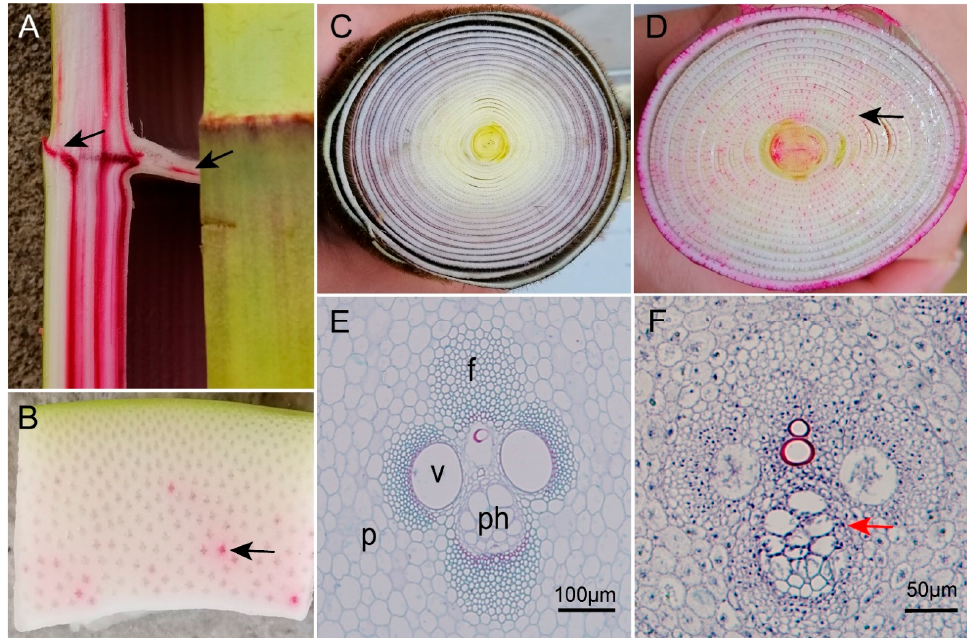
Figure 4. ( A ) Bamboo shoot stained with magenta; ( B ) Cross-cut section view of the culm in panel A. ( C ) Unstained bamboo sheaths. ( D ) Bamboo sheaths stained with magenta. ( E ) The vascular bundles at the base of a bamboo shoot; ( F ) The vascular bundles at the upper of a bamboo shoot; the black arrow indicates vascular bundles stained with magenta; the red arrow indicates nucleus. v, vessel element; ph, phloem; P, parenchyma; f, fiber cells. Forests 2022 , 13 , x FOR PEER REVIEW